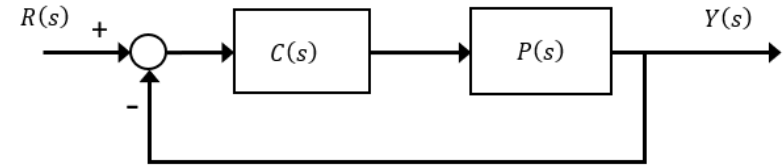
Figure 1. Unity feedback